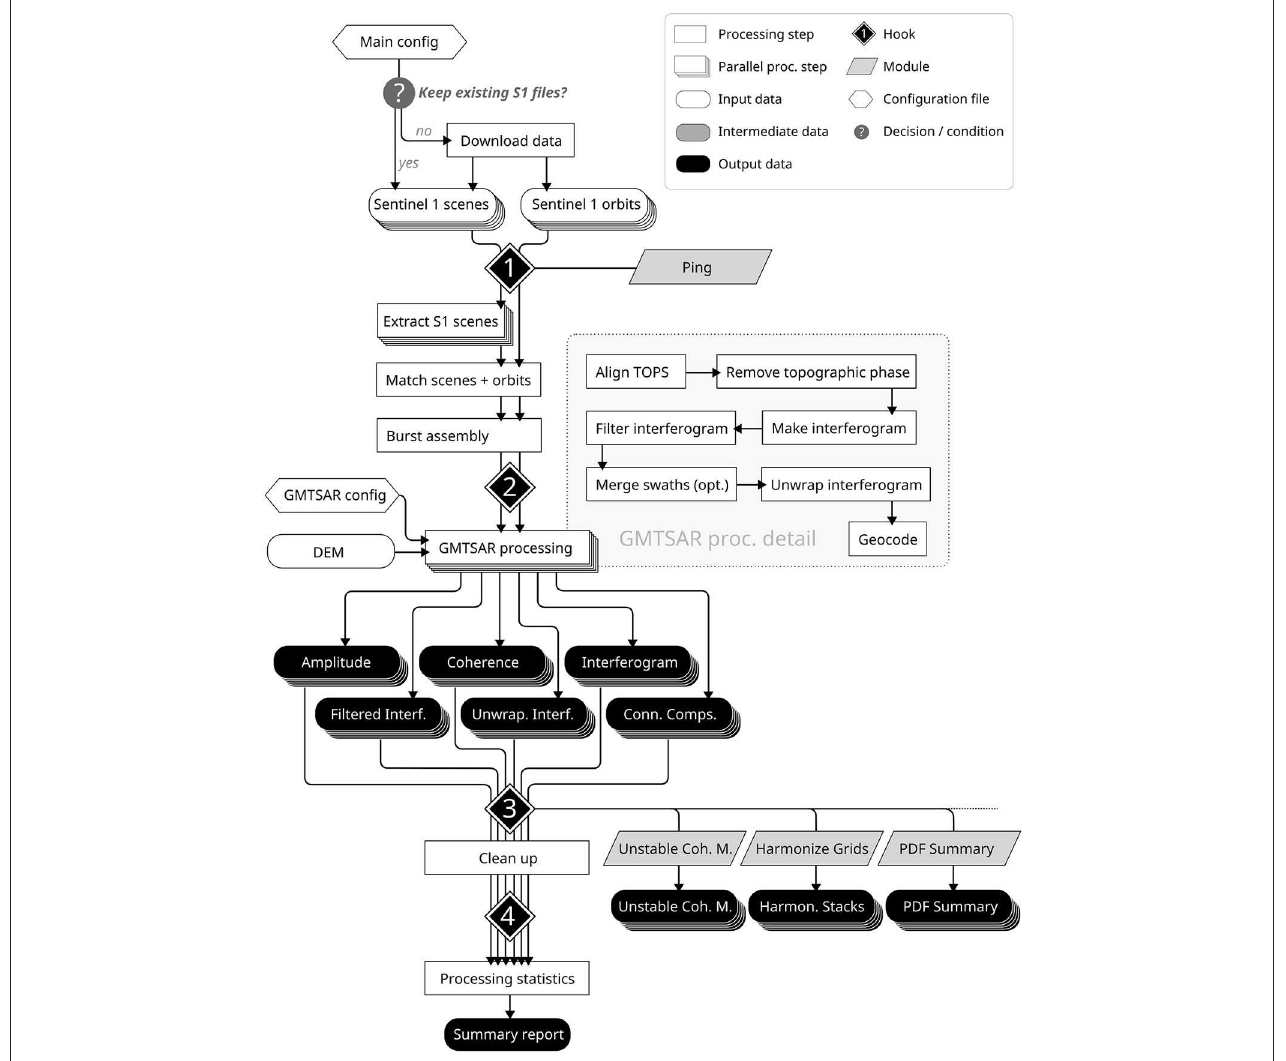
FIGURE 3 | OSARIS processing scheme. The module setup presents an excerpt of key modules used in the case study (cf. section